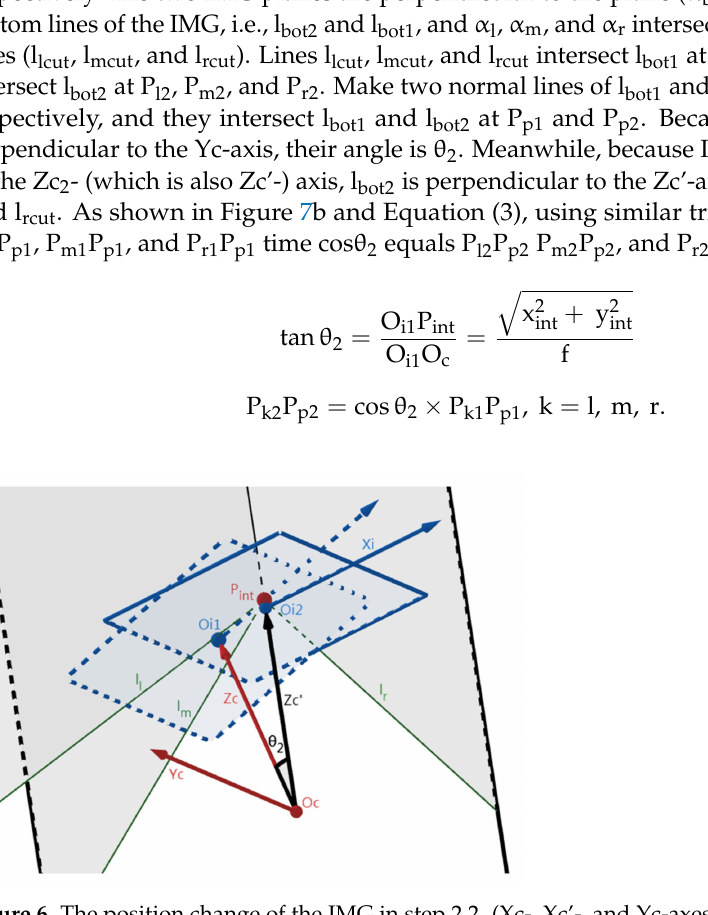
Figure 6. The position change of the IMG in step 2.2. (Xc-, Xc’-, and Yc-axes are omitted).